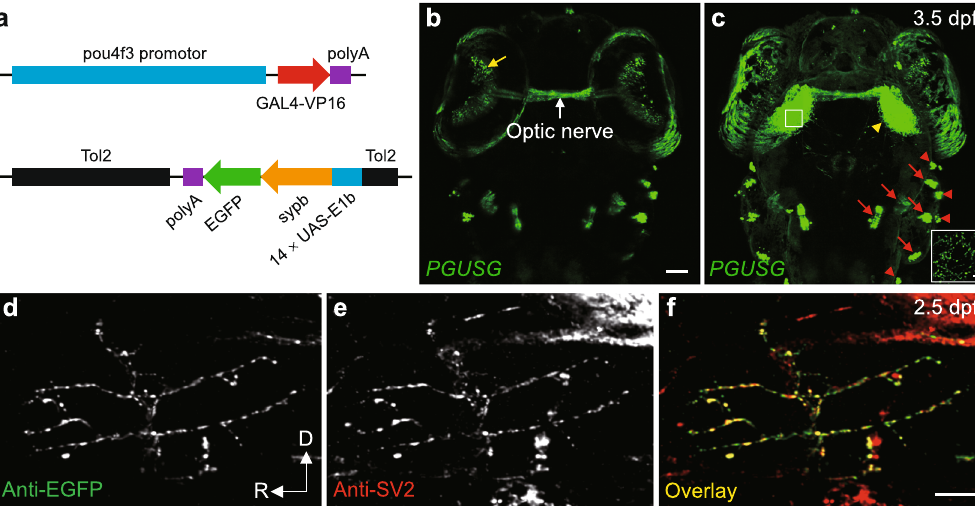
Figure 1. Visualization of RGC pre-synaptic terminals in double transgenic zebrafish PGUSG . ( a ) Schematic of the DNA constructs used for generating the GAL4 line Tg(pou4f3:GAL4-VP16) ( PG ) and the UAS line Tg(14 × UAS-E1b:sypb-EGFP) ( USG ). ( b , c ) Dorsal views of a PGUSG double transgenic larva at 3.5 dpf showing EGFP expression in RGCs (soma in the retina, yellow arrow; axonal arbors in the tectal neuropil, yellow arrow head) and mechanosensory hair cells of the inner ear (red arrow) and lateral line (red arrow head). Images in ( b ) and ( c ) are the maximum-intensity-projection view of more ventral z-stack and the whole z-stack, respectively. Inset in ( c ), zoom-in view of a single optical section of the boxed area in left tectal neuropil showing the punctate signal of Sypb-EGFP on RGC axonal arbor. The optic nerve (white arrow) is visible. The nasal is upwards. Scale bar, 50 μ m for each panel; 5 μ m for inset. ( d–f ) Confocal images of single spinal motor neuron in EGUSG (see Methods) double immuno-labelled with EGFP ( d ) and SV2 ( e ) antibodies at 2.5 dpf. Colocalization of Sypb-EGFP with pre-synaptic SV2 is demonstrated by the overlap ( f , yellow) of anti-EGFP and anti-SV2 puncta. D, dorsal; R, rostral. Scale bar, 10 μ